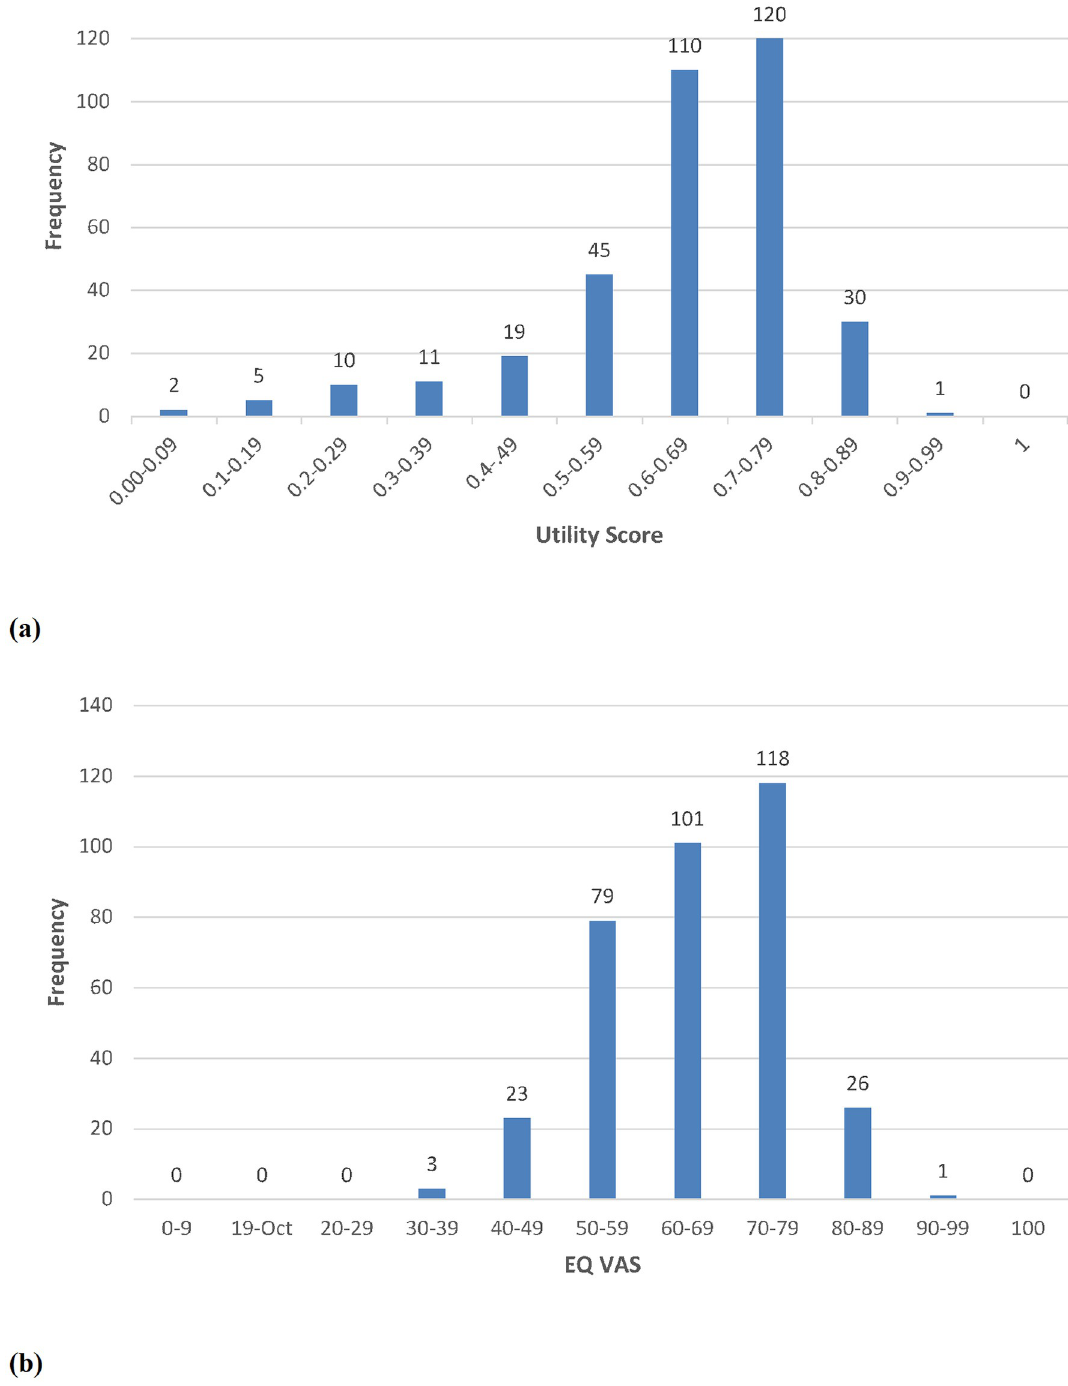
Fig 1. (a) Utility Scores of hypertensive patients (N = 350) (b) EQ Visual Analogue Scale (EQ VAS) of hypertensive patients (N = 350).